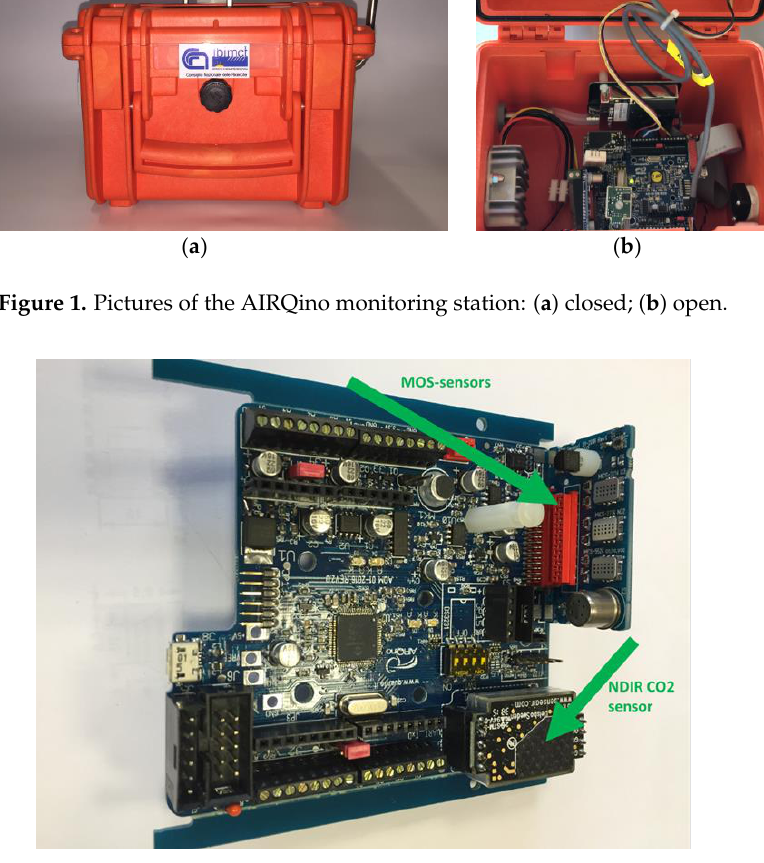
Figure 2. Picture of the integrated circuit board.